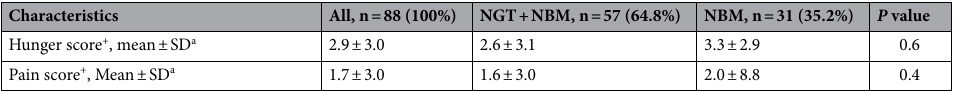
Table 1. Clinical Characteristics between the NGT + NBM and NBM groups. * P < 0.05 for comparison between NGT and NBM groups. a SD: Standard deviation. b PPI: Proton Pump Inhibitor. c